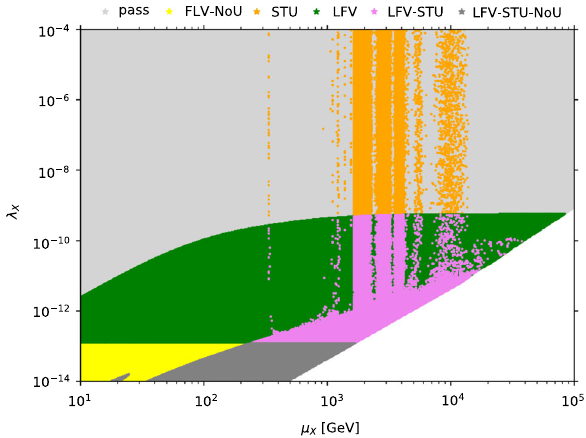
Fig. 9 Scatter plot in the μ X and λ X plane starting from the parameter point P1 . The color code is used to distinguish between points that pass all three constraints LFV, STU, NoU (light gray), that do not pass any of the three constraints (dark gray) and that violate individual constraints or combinations of two constraints: LFV (green), STU (orange), LFV and STU (pink), LFV and NoU (yellow). See text for